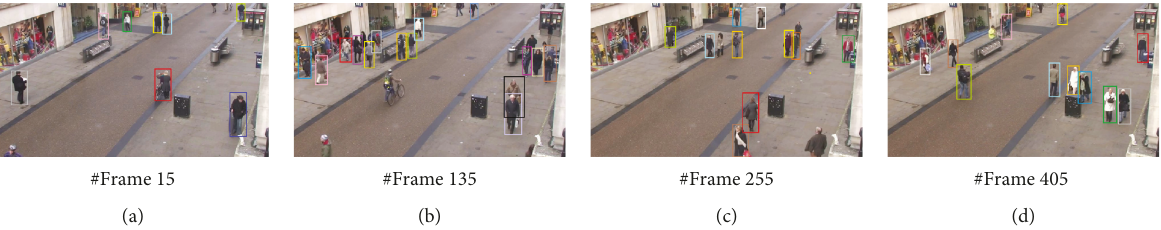
Figure 10: Qualitative tracking results of our tracker on AVG-TownCentre.